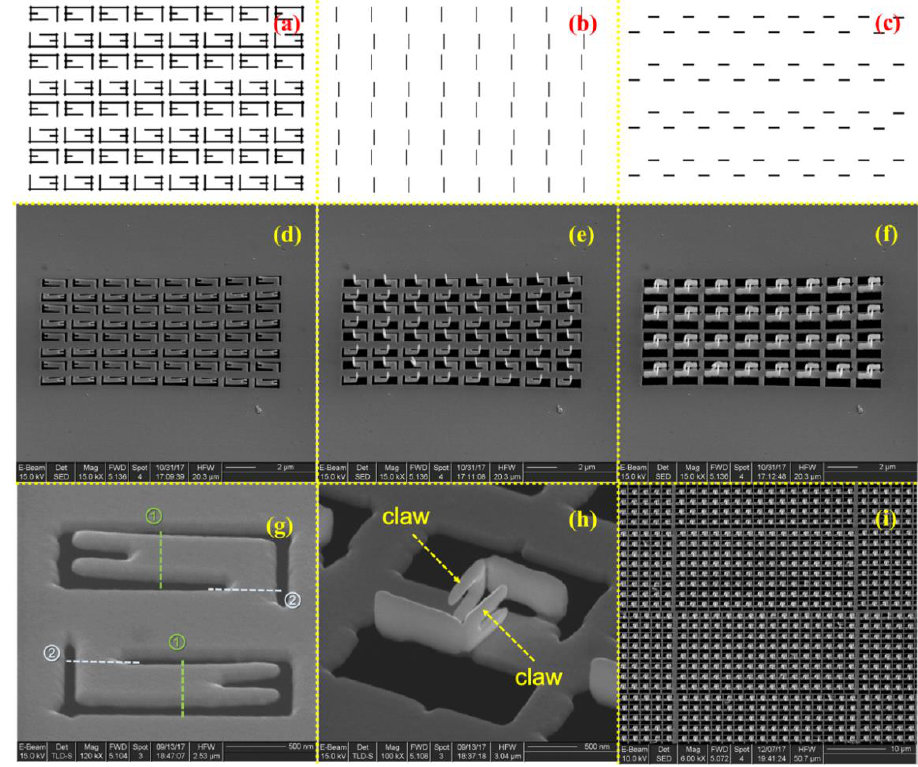
Figure 6. Main fabrication steps and process details of the designed 3D meta-atom array based on the FIB-SID technique. ( a ) unfolding 2D pattern figure and ( b , c ) the 3D transformation figures for FIB process, ( d ) unfolding 2D patterning using the FIB milling function to irradiate as ( a ) drawing, ( e , f ) 3D transformation process using the FIB-SID technique to irradiate as ( b , d ) drawing, ( g ) a unit cell of unfolding 2D patterned structure which marked irradiation area of FIB-SID process as dotted line, ( h ) a unit cell of completed 3D meta-atom array with two coupled claws facing to each other, ( i ) a part of large scale 3D meta-atom array fabricated using this method. The scale bars are 2 μm for ( d – f ), 500 nm for ( g , h ) and 10 μm for ( i ).